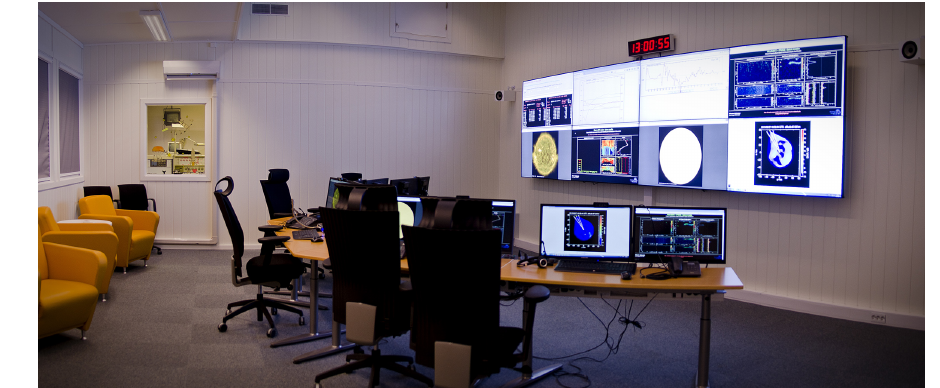
Figure 13. The science operation centre